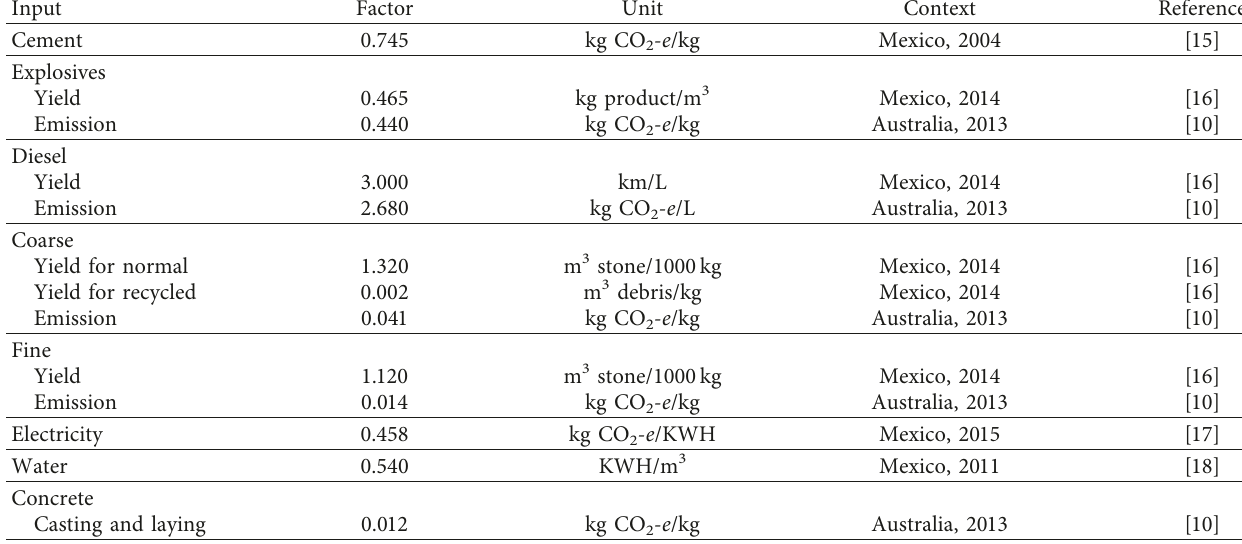
Figure 2: CO 2 - e emission system for the concrete Table 3: Inventory of CO 2 - e , energy, and materials.